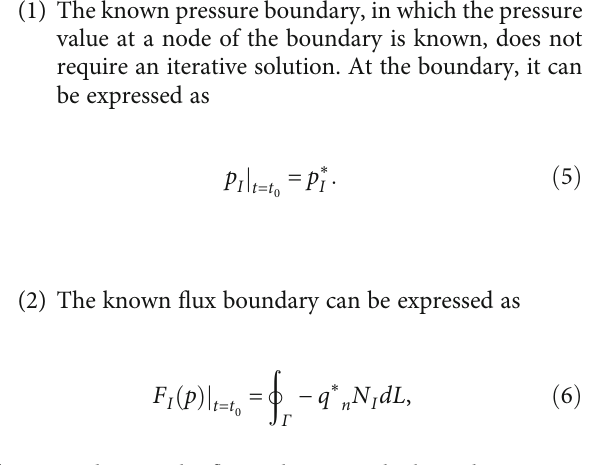
Figure 7: Change in single-day mass fl ux with time in di ff erent fracture